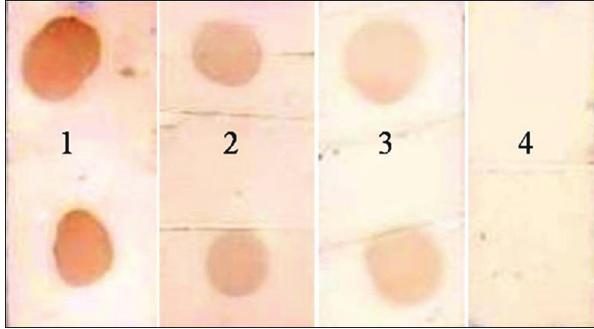
Figure-2: Representative dot strip no. 1-3 (1 - heavy, 2 - moderate, and 3 - light) and 4 showing positive and negative reactivity of Fasciola gigantica infection,